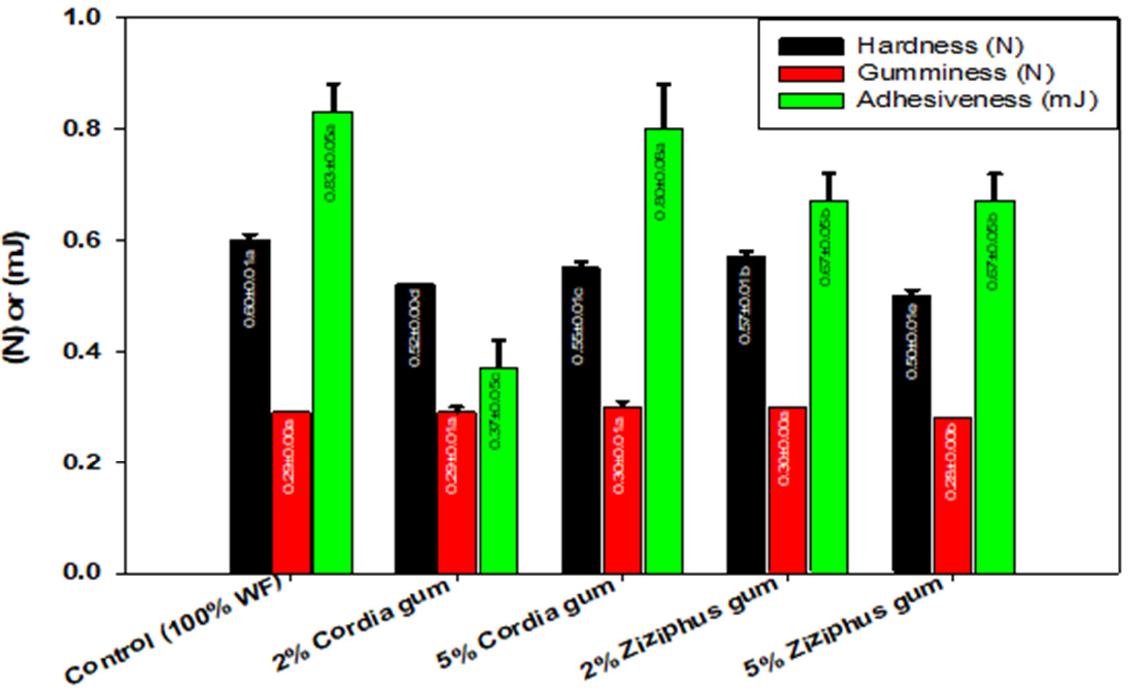
Figure 2. Textural properties of wheat flour dough mixed with Cordia and Ziziphus gum blends. Values followed by different letters in same color bars are significantly different at p ˂ 0.05 .